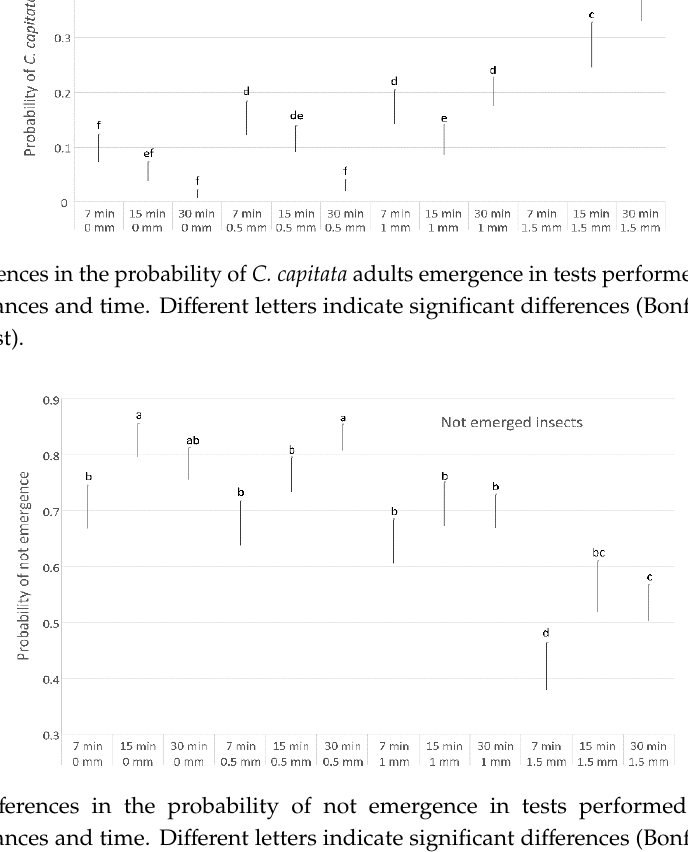
Insects 2019 , 10 , x FOR PEER REVIEW